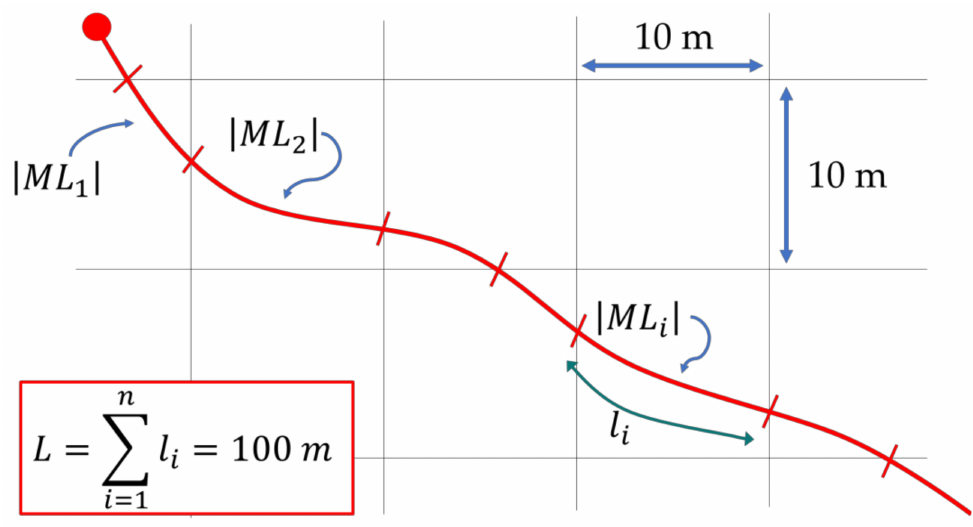
Figure 11. Computation of ML NWSA